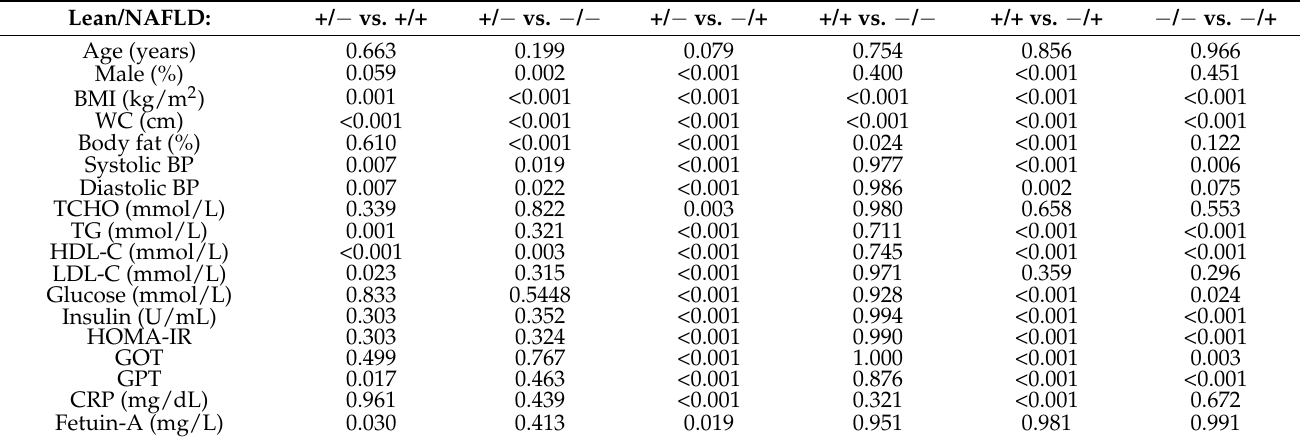
Table 2. Comparison of lean, non-lean, NAFLD, and non-NAFLD groups in metabolic variables.